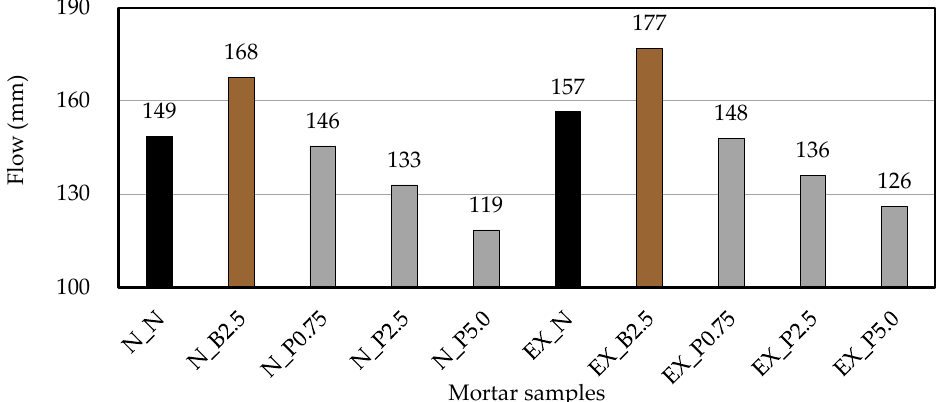
Figure 3. Flow in the fresh mortar. (black: without NFBC, brown: with NFBC type B f , grey: with NFBC type P f ).